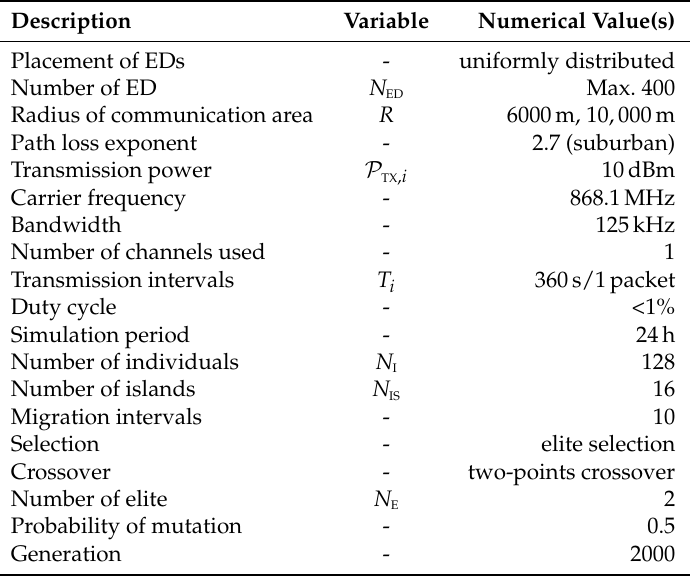
Table 4. Parameter